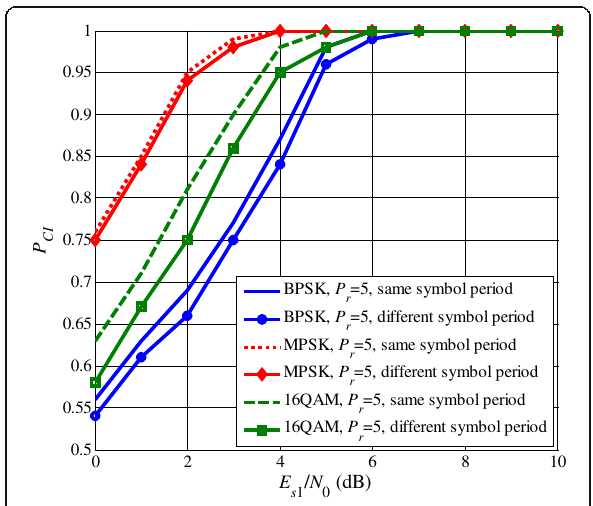
Fig. 5 The P CI as a function of the power ratio P r